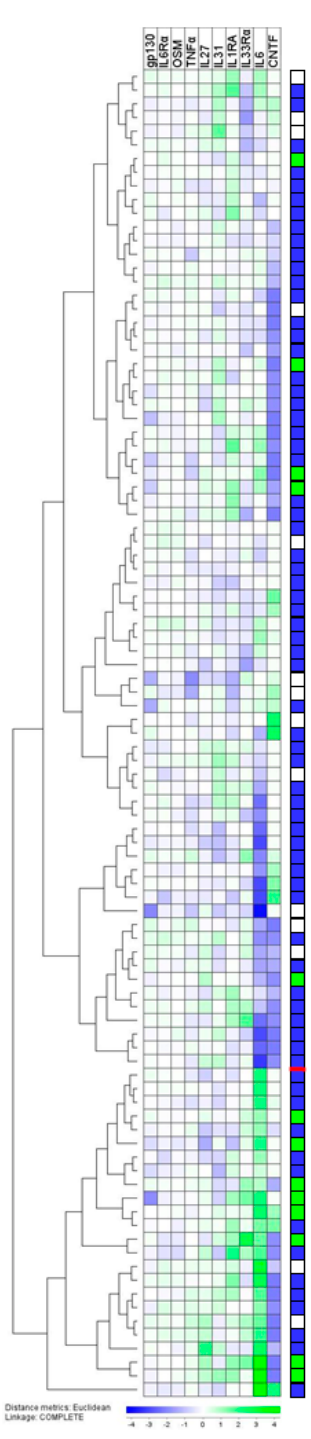
Figure 4. (see page 10). The serum profile of the acute phase cytokines in patients with renal cancer; a hierarchical cluster analysis including IL6 family cytokines (IL6, IL6R α , gp130, IL27, IL31, CNTF, and OSM), two IL1 cytokine family mediators (IL1RA and IL33R α ), and TNF α . The mediators are indicated at the top of the figure, and the patient clustering is shown to the left. The survival of individual patients is summarized in the right part of the figure and shows patients still alive (blue), dead from renal cancer disease (green), and dead from other causes